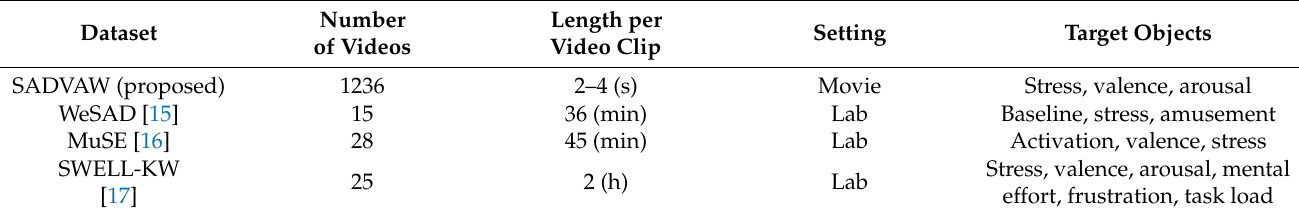
Table 1. Comparision of the SADVAW dataset with the existing stress datasets WeSAD [15], MuSE [16], and SWELL-KW [17].